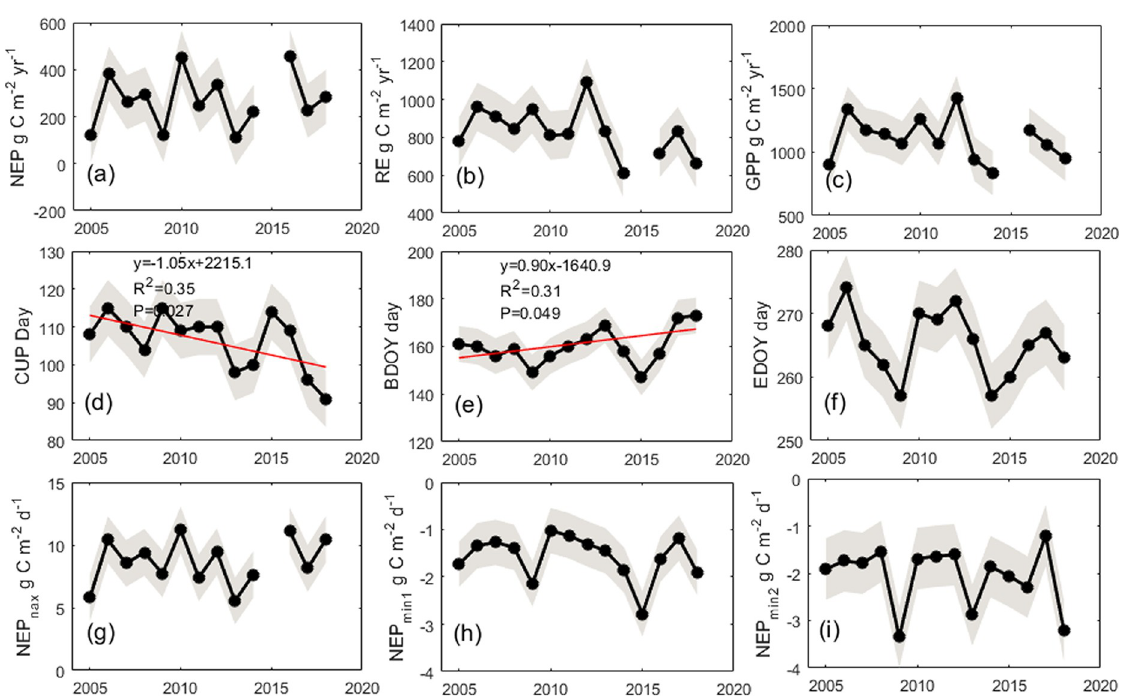
Fig 2. Annual values of net ecosystem production (NEP, a), ecosystem respiration (RE, b), gross ecosystem production (GEP, c), carbon dioxide uptake period (CUP, d), the beginning (BDOY, e) and ending date (EDOY, f) of net carbon dioxide uptake, maximum daily net ecosystem production (NEP max , g), and minimum daily net ecosystem production (NEP min_begin, h, and NEP min_end , i). Red line indicates that there was a significant linear regression over time. Grey shading indicates standard deviation. https://doi.org/10.1371/journal.pone.0237684.g002 positive correlations with LAI which was controlled by VPD, SWC and Ts. The standardized indirect effects of SWC, Ts and LAI on annual anomalies in NEP were 0.55, 0.19 and 0.16, respectively. VPD, PPT and Ta also indirectly affected annual anomalies in NEP by controlling